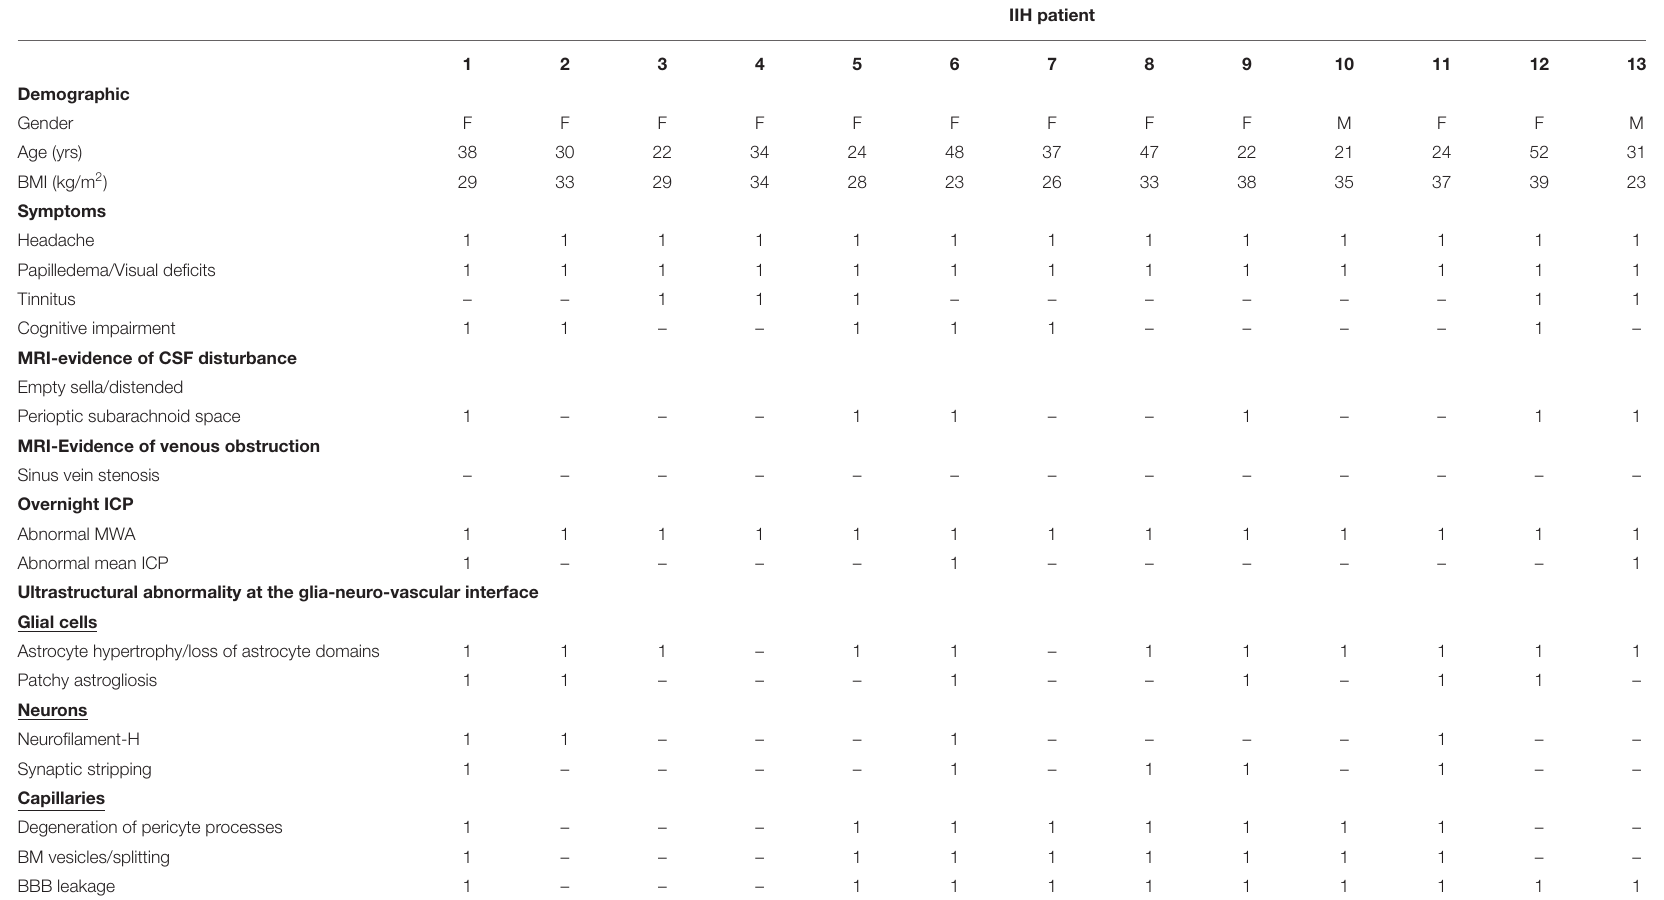
TABLE 1 | Variables indicative of idiopathic intracranial hypertension (IIH) pathophysiology in the 13 patients with definite